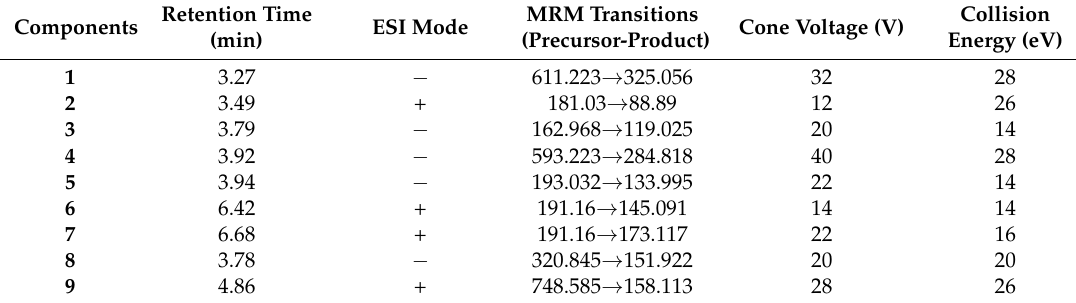
Table 5. The retention time (t R ), optimized MS/MS transitions, cone voltage, and collision energy for each